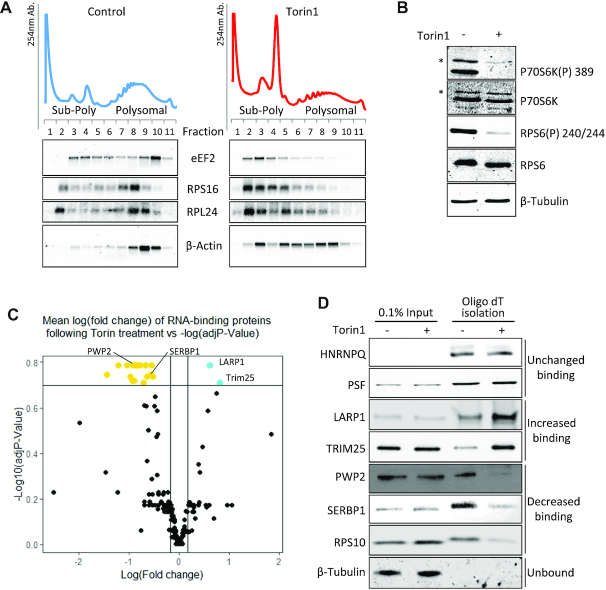
Changes in RNA-binding proteins upon mTOR inactivation. (A–D) HeLa cells were treated with 200 nM Torin1 or DMSO as control. (A) Polysome profiling was performed and RNA from fractions was analysed by Northern blot. Representative UV traces from one of two independent experiments and corresponding blots from gradient fractions using probes against indicated RNAs are shown. B–D: Whole cell RNA-binding protein (RBP) capture using oligo(dT) affinity isolation. (B) Representative western blots of lysates from one of three experiments used for oligo(dT) pulldowns in C and D to show mTOR inactivation and equal loading using indicated antisera. Asterisks denote p85S6K. (C) Plot of mean fold change of proteins identified in control (DMSO carrier) versus Torin1 (mTOR inhibited) RBP capture (using TOP3 unique peptides for quantitation). Cut-offs shown on graph are log FC > 1.3, adjusted P-values <0.2 using Benjamini–Hochberg adjusted P-value. Following Torin1 treatment: gold = RBP decreasing binding; cyan = RBP increasing binding; black = no significant change in binding. Three independent experiments performed. (D) Validation of changes in RNA-binding proteins upon mTOR inactivation. Representative western blots of proteins changing their RNA binding following mTOR inhibition from independent oligo(dT) pulldowns n = 5.